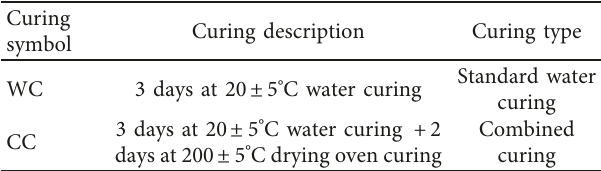
Table 14: Two curing applications for the production of inter- locked paving